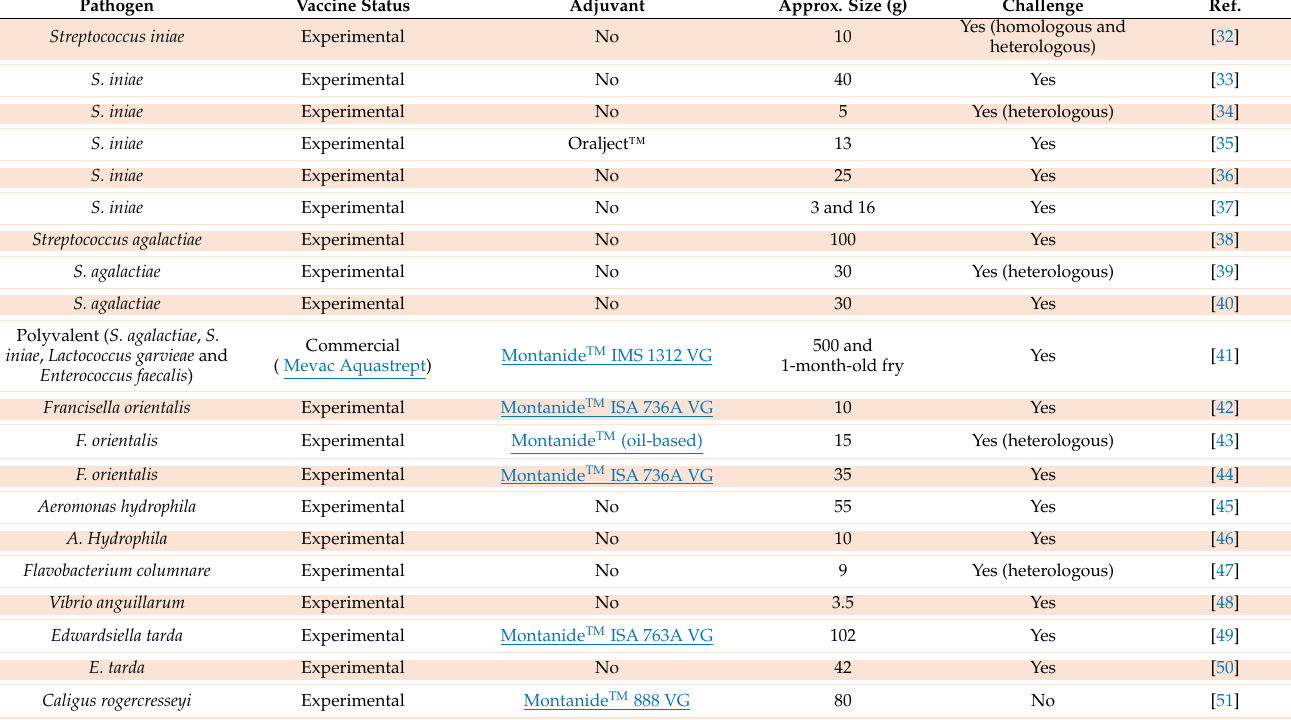
Table 2. Literature regarding experimental and commercial vaccines herein presented and discussed for Nile tilapia Oreochromis niloticus . Approximate size refers to the fish BW at the time of challenge or RPS calculation, as stated in or inferred from references. In case of commercial vaccines, the product description was linked. Challenges must be intended as homologous except when stated